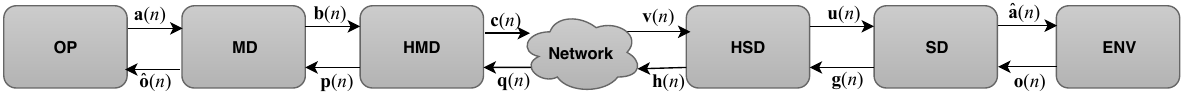
Figure 1. Proposed discrete model of the tactile internet